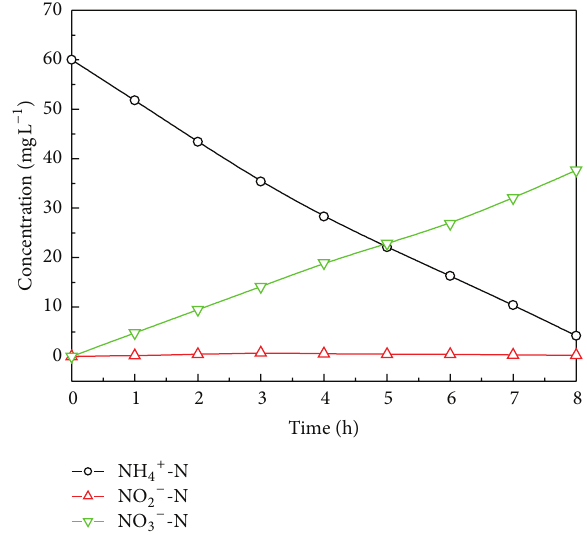
Figure 7: Variation of ammonium, nitrite, and nitrate in batch test.